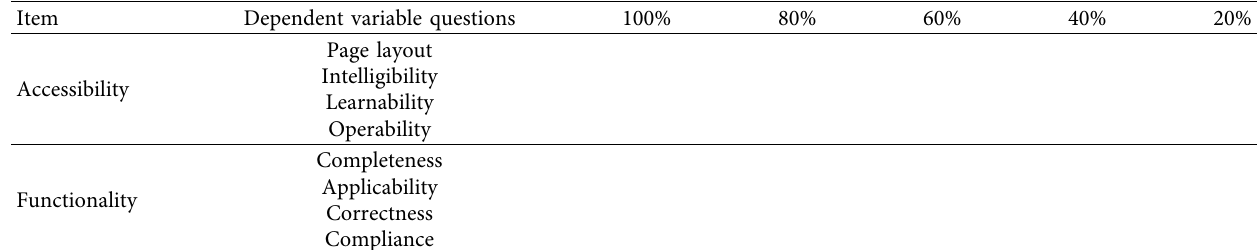
Table 22: Questionnaire feedback of AI fre-fghting